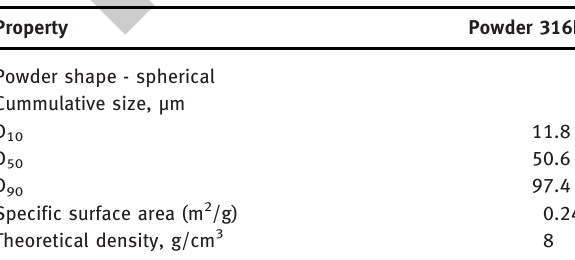
Table 1: Characteristics of the as-received powders used in the present